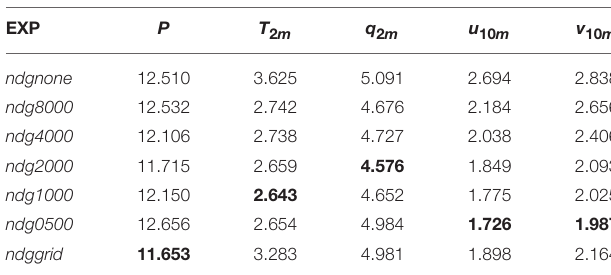
TABLE 3 | RMSE during the SACZ event for near surface variables: precipitation ( P ), air-temperature at 2 m ( T 2 ), specific humidity at 2 m ( q 2 ) and zonal ( u 10 ) and meridional ( v 10 ) components of the wind at 10